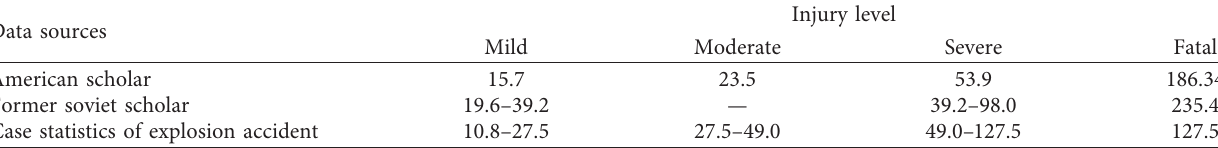
Table 4: Traditional damage criteria of shock wave overpressure to human bodies (unit: kPa).